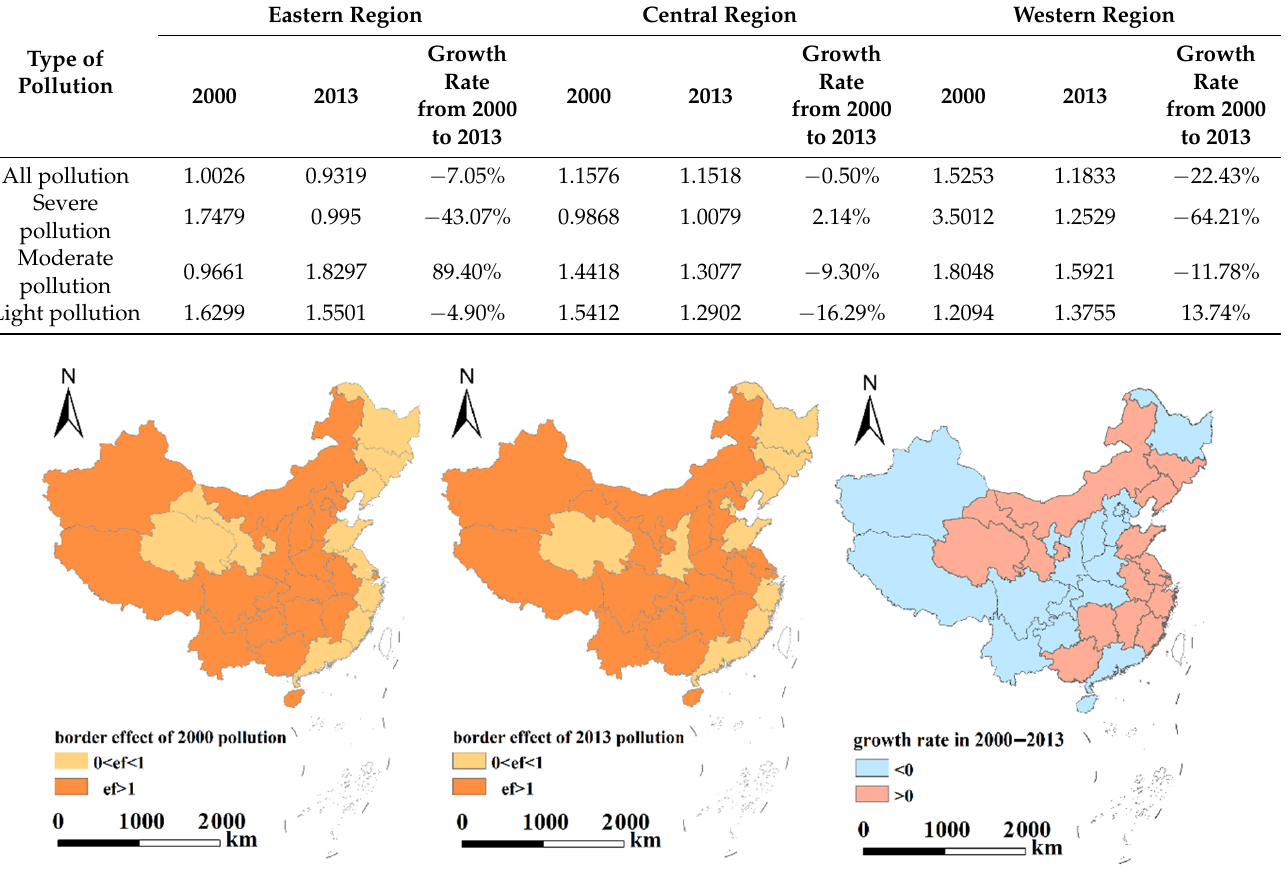
Figure 2. Transboundary pollution effects at the provincial level (all types of polluting enterprises).